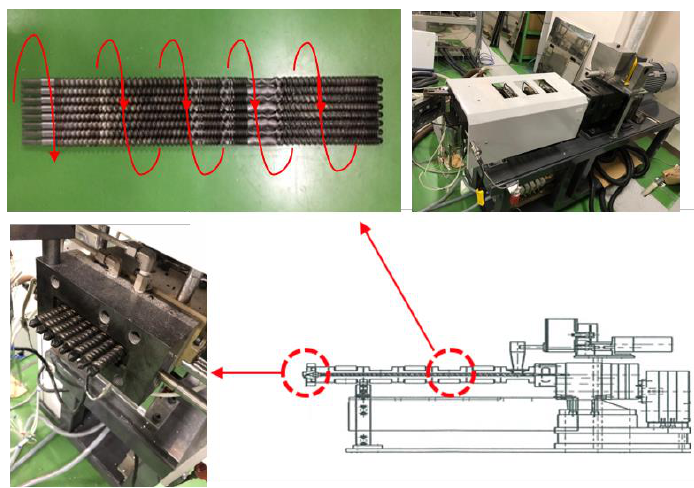
Figure 1. Photos of the octa-screw extruder used for the experiments.